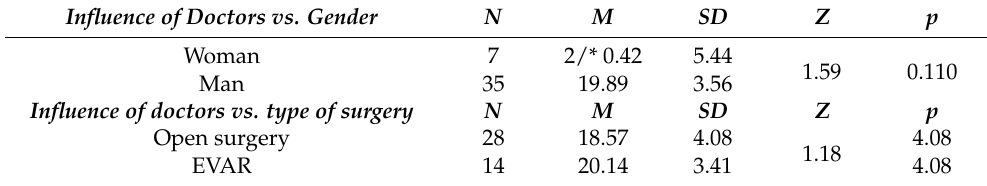
Table 5. Influence of doctors vs. gender. Influence of Doctors vs. Gender